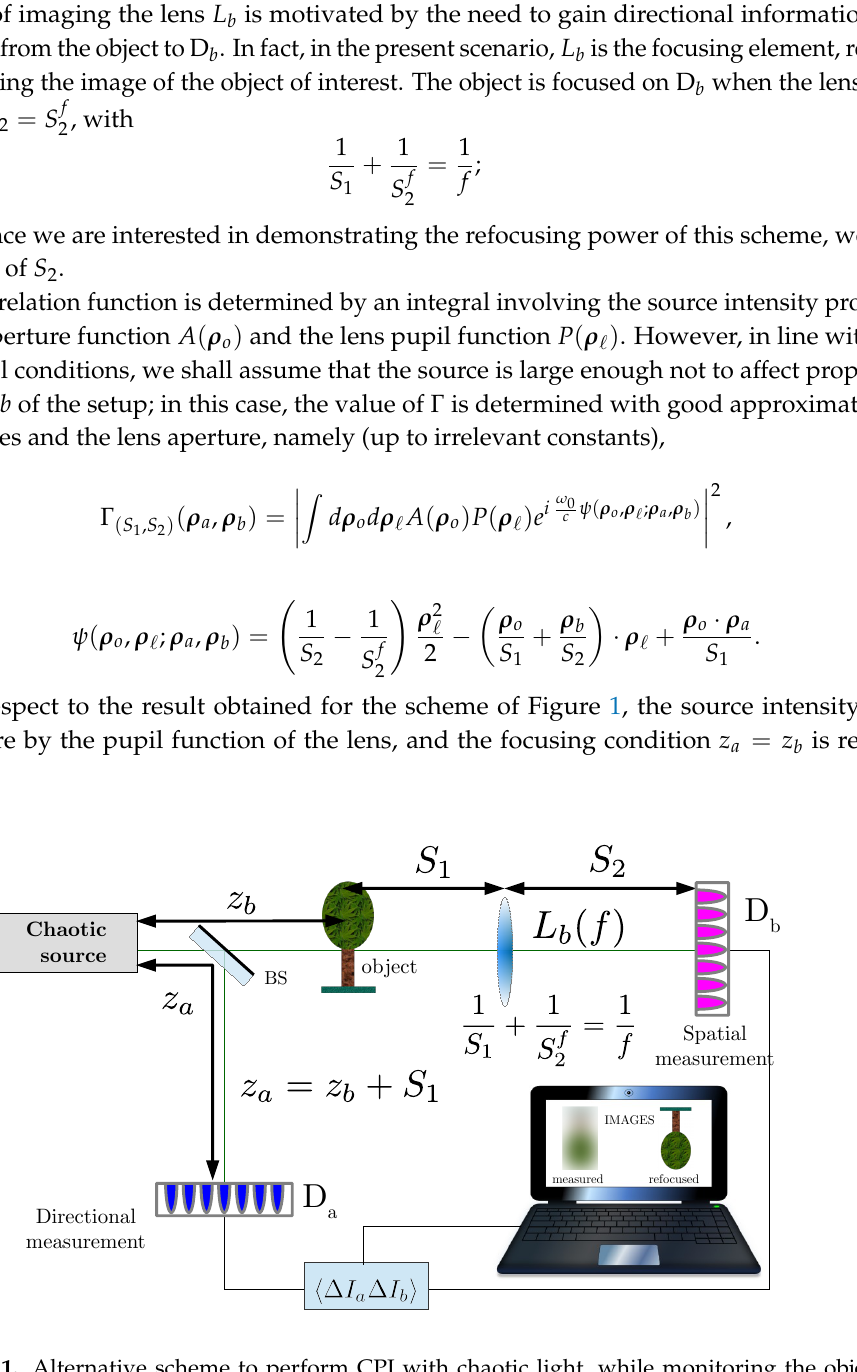
Figure 11. Alternative scheme to perform CPI with chaotic light, while monitoring the object by standard imaging. The lens L b reproduces the image of the object on detector D b , thus playing the role of the focusing element. The (ghost) image of this lens is retrieved on D a by correlation measurements. Information on the direction of light from the object plane to the lens, as given by the correlation of intensity fluctuations, enables refocusing objects placed out of the conjugate plane of the object, namely at S 2 (cid:54) = S f 2